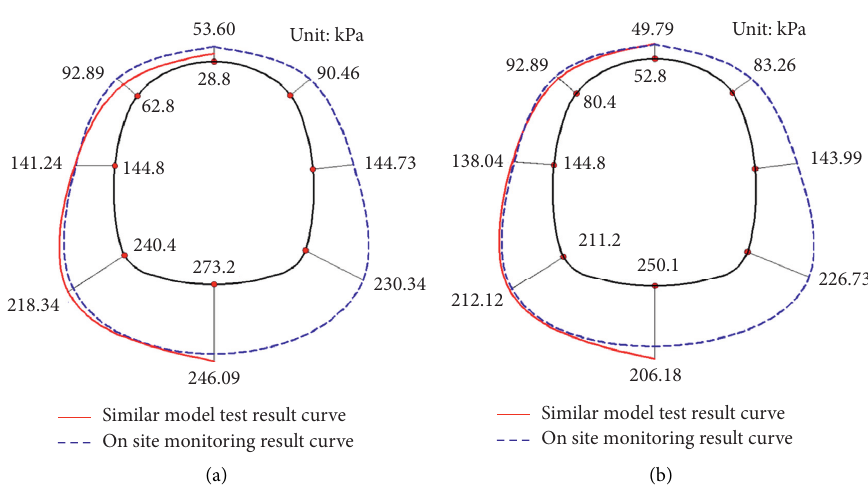
Figure 27: Comparison of indoor similar test and in situ monitoring results. (a) Water pressure outside the tunnel pipe roof and the initial support. (b) Water pressure outside the waterproof board and the